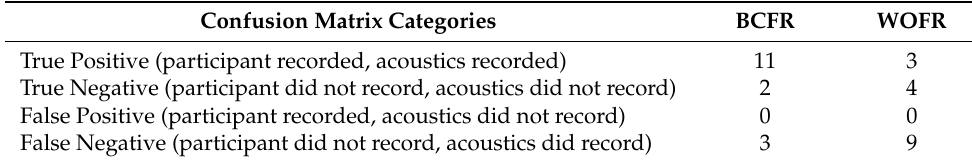
Table 1. Confusion matrix categories comparing citizen science and autonomous recording unit reports at 16 wetland sites over two years for boreal chorus frog Pseudacris maculata (BCFR) and wood frog Lithobates sylvaticus (WOFR) in Calgary, Alberta, Canada.